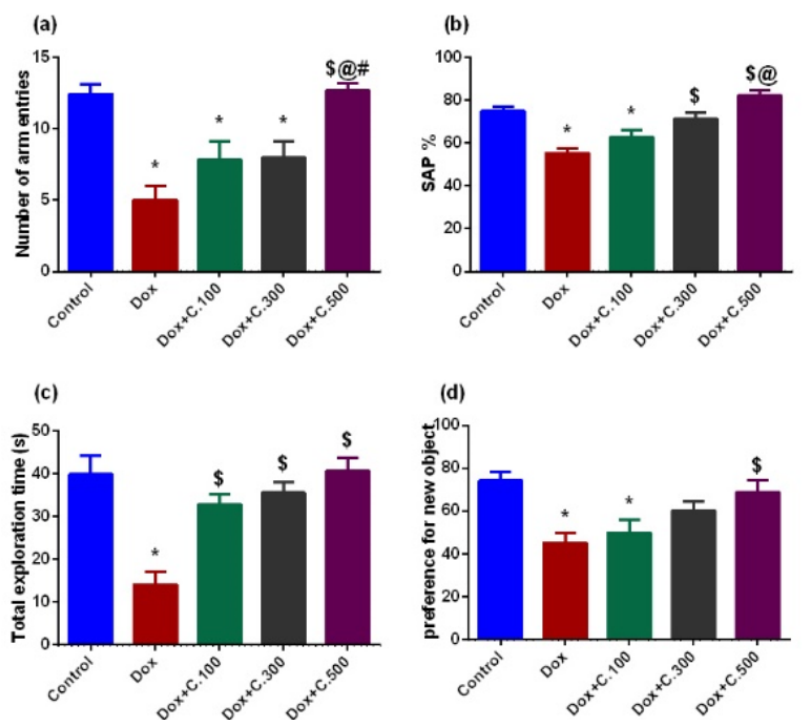
Figure 1. Effect of Dox with or without different doses of C. macrocarpa leaves polar fraction on the cognitive functions of rats. ( a ) Y-maze: Number of arm entries, ( b ) Y-maze: Spontaneous alternation percentage, ( c ) Novel object recognition test: Total exploration time, and ( d ) Novel object recognition test: Preference for new object. Data are expressed as mean ± SEM, one-way ANOVA followed by post-hoc test Tukey test for seven rats in each group. * Significant from control group, $ Significant from Dox group, @ Significant from Dox+ C.100 group, and # Significant from Dox+ C.300 group, p <